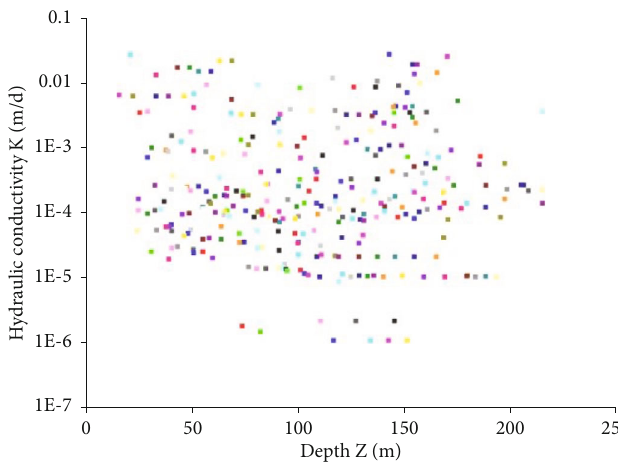
Figure 5: Scatter diagram of hydraulic conductivity distribution in study